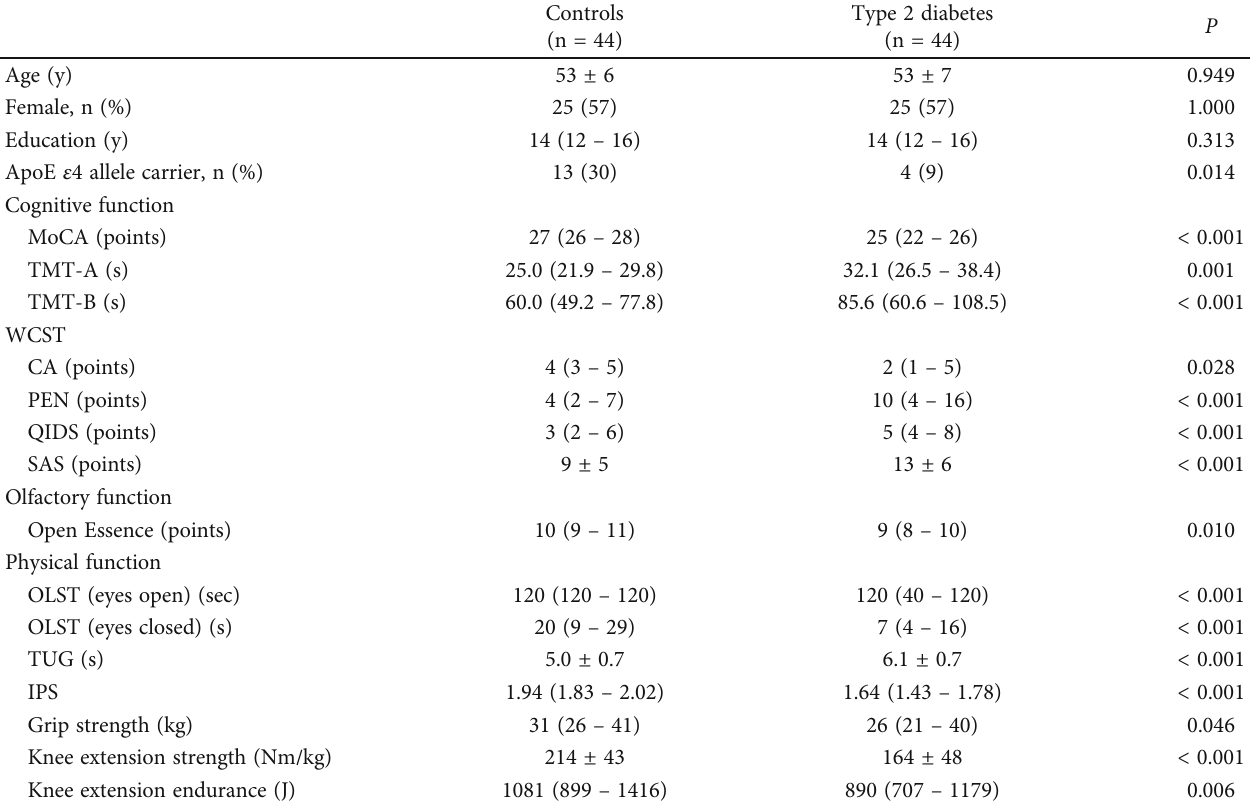
Table 8: Comparison of cognitive function tests, odor identi fi cation tests, and physical function tests in age-, sex-, and years of education- matched